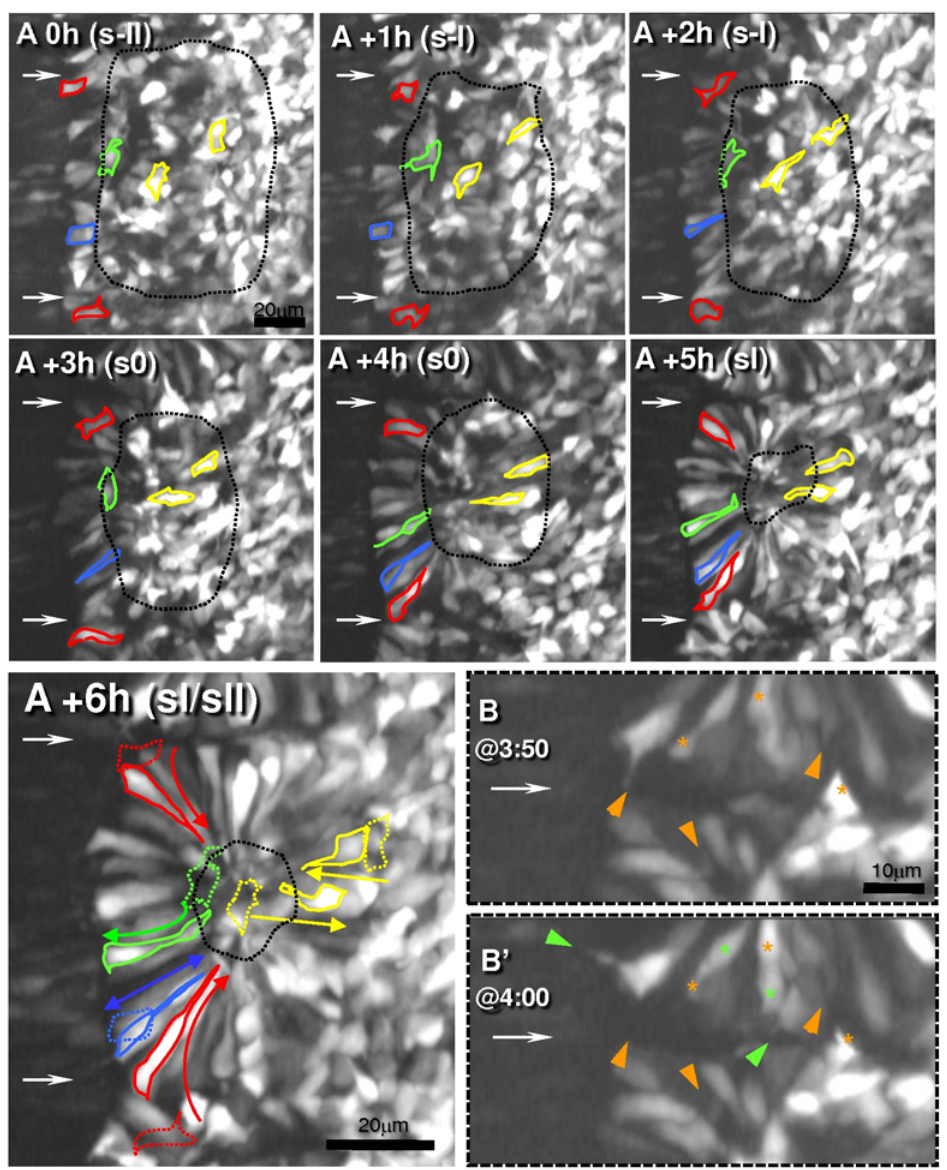
Figure 2. Morphogenetic movements during somite formation in chick embryos (see also Video S3). A ) Panels represent seven time- points (spaced 1 hour) of a 4D two-photon imaging sequence (each is a 3D reconstructed 30 m m coronal ‘‘slab’’ through the somite’s equator (rostral is to the top, medial to the left) of embryos expressing a mosaic of GFP-positive and negative cells. Thin horizontal arrows point to areas where intersomitic boundaries form. Five cells were traced (outlined in color) to depict different morphogenetic movements: i ) Cuboidal medial cells elongate and become spindle-shaped (blue). ii ) Some cells are recruited to the medial epithelium via accretion (red) and undergo a change in shape and orientation to conform to the orientation of medial elongated cells. iii ) Lateral PSM cells and core mesenchymal cells (both yellow) converge and elongate. iv ) Core cells egress (green) into the epithelium, becoming spindle-shaped and centripetally aligned. In the last panel (A + 6h) the initial positions of the cells (A + 0h) are drawn with dotted lines, and colored arrows represent the overall morphogenetic movements. The size of the mesenchymal region, i.e. the somitocoel (black dotted lines) becomes progressively smaller during these 6 hours. B ) Detailed view of time-points 3:50 (B) and 4:00 (B 9 ) showing pseudopodia retracting (orange arrowheads) and new ones forming (green arrowheads), similar to the tapering extension observed in fixed embryos (see Figure 1D and last segment of Video S3). Furthermore, massive cytoplasm movements inside cells are also visible (asterisks; where green marks cytoplasm translocations; see also Video S3). These movements occurred throughout the image recording period indicating that the dynamic behavior was retained even after cells became epitheloid. doi:10.1371/journal.pone.0007429.g002 elongation and alignment abnormalities (Figure 3F), the cells of fragment-treated explants also show impaired N-cadherin polar- (Figure 4C). In contrast, the two equivalent tissues in fragment- ization which in ‘‘s0’’ is most severe caudally. treated explants have no obvious apical polarization of N-cadherin (‘‘s-II’’; Figure 4E) or have a defective ‘‘3D adhesion’’ basket with We further noticed that perturbing the FN matrix also affects the caudal side opened (‘‘s0’’; Figure 4F). Thus in addition to cell somites that were already formed before culture. In control